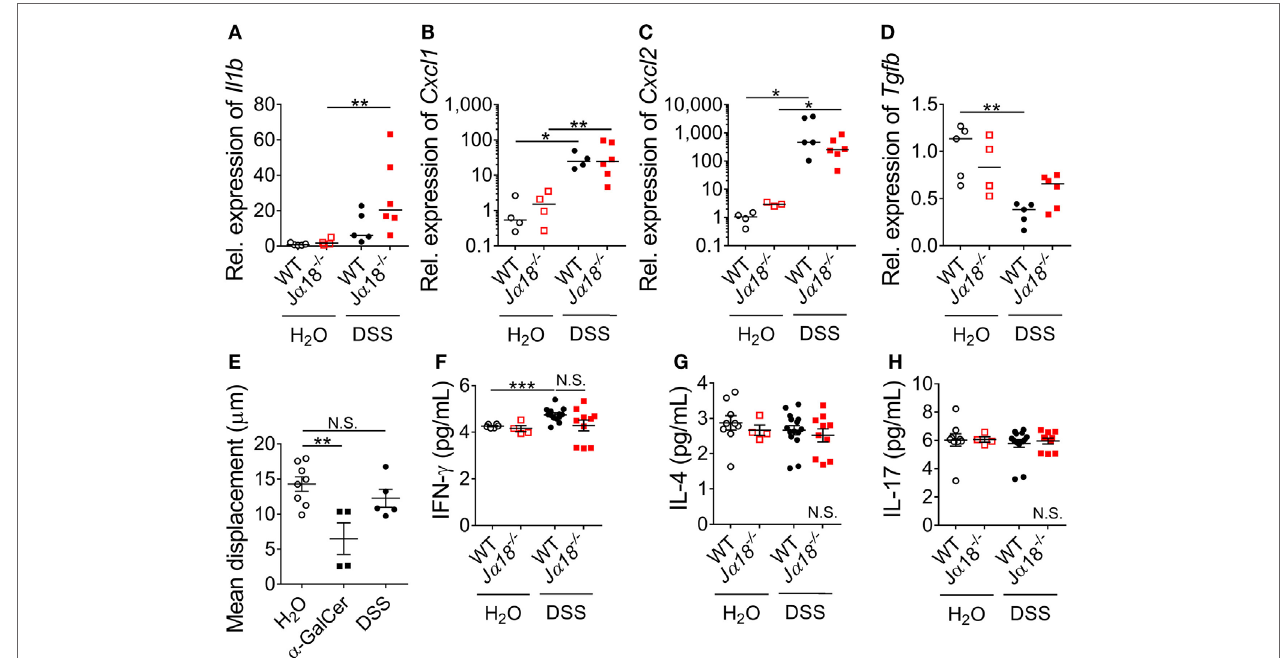
FigUre 3 | Systemic and local effects of dextran sodium sulfate (DSS) administration in wild type (WT) and J α 18 − / − mice. (a–D) Expressions of genes in the colon were quantified by qPCR and expressed relative to WT H 2 O controls. Lines represent median and Mann–Whitney U -test was performed. (e) Mean displacement of liver iNKT cells were quantified in Cxcr6 gfp/ + mice provided with normal H 2 O, injected with α -GalCer i.p., or administered 2% DSS for 7 days. (F–h) In a separate group, serum cytokine levels of WT and J α 18 − / − mice at day 7 were measured using cytometric bead array (CBA). For (e–h) , data represent mean ± SEM, and Student’s t -test was performed. n ≥ 3. Significance is represented by * p < 0.05, ** p < 0.01, and *** p < 0.001. N.S. denotes not significant. These data were obtained from at least two independent